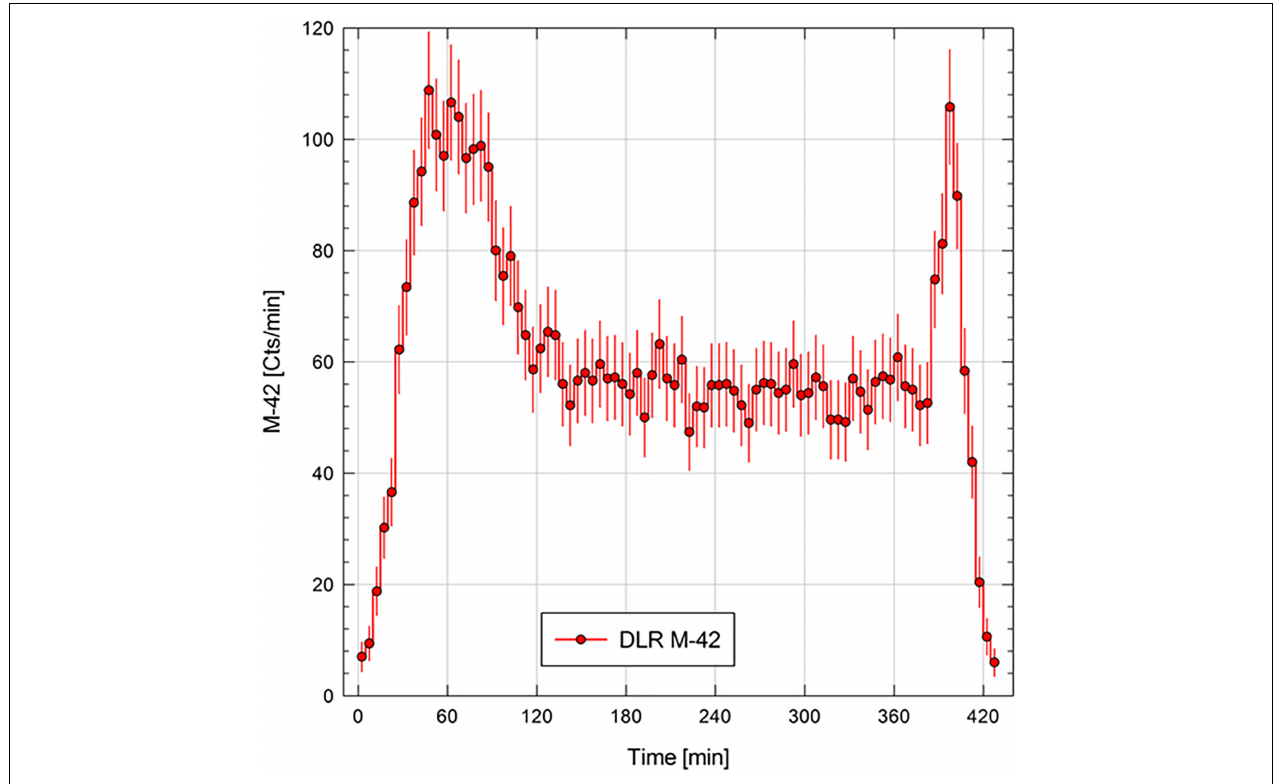
FIGURE 5 | The M-42 count rate (cts min − 1 ) measured for the MARSBOx balloon flight